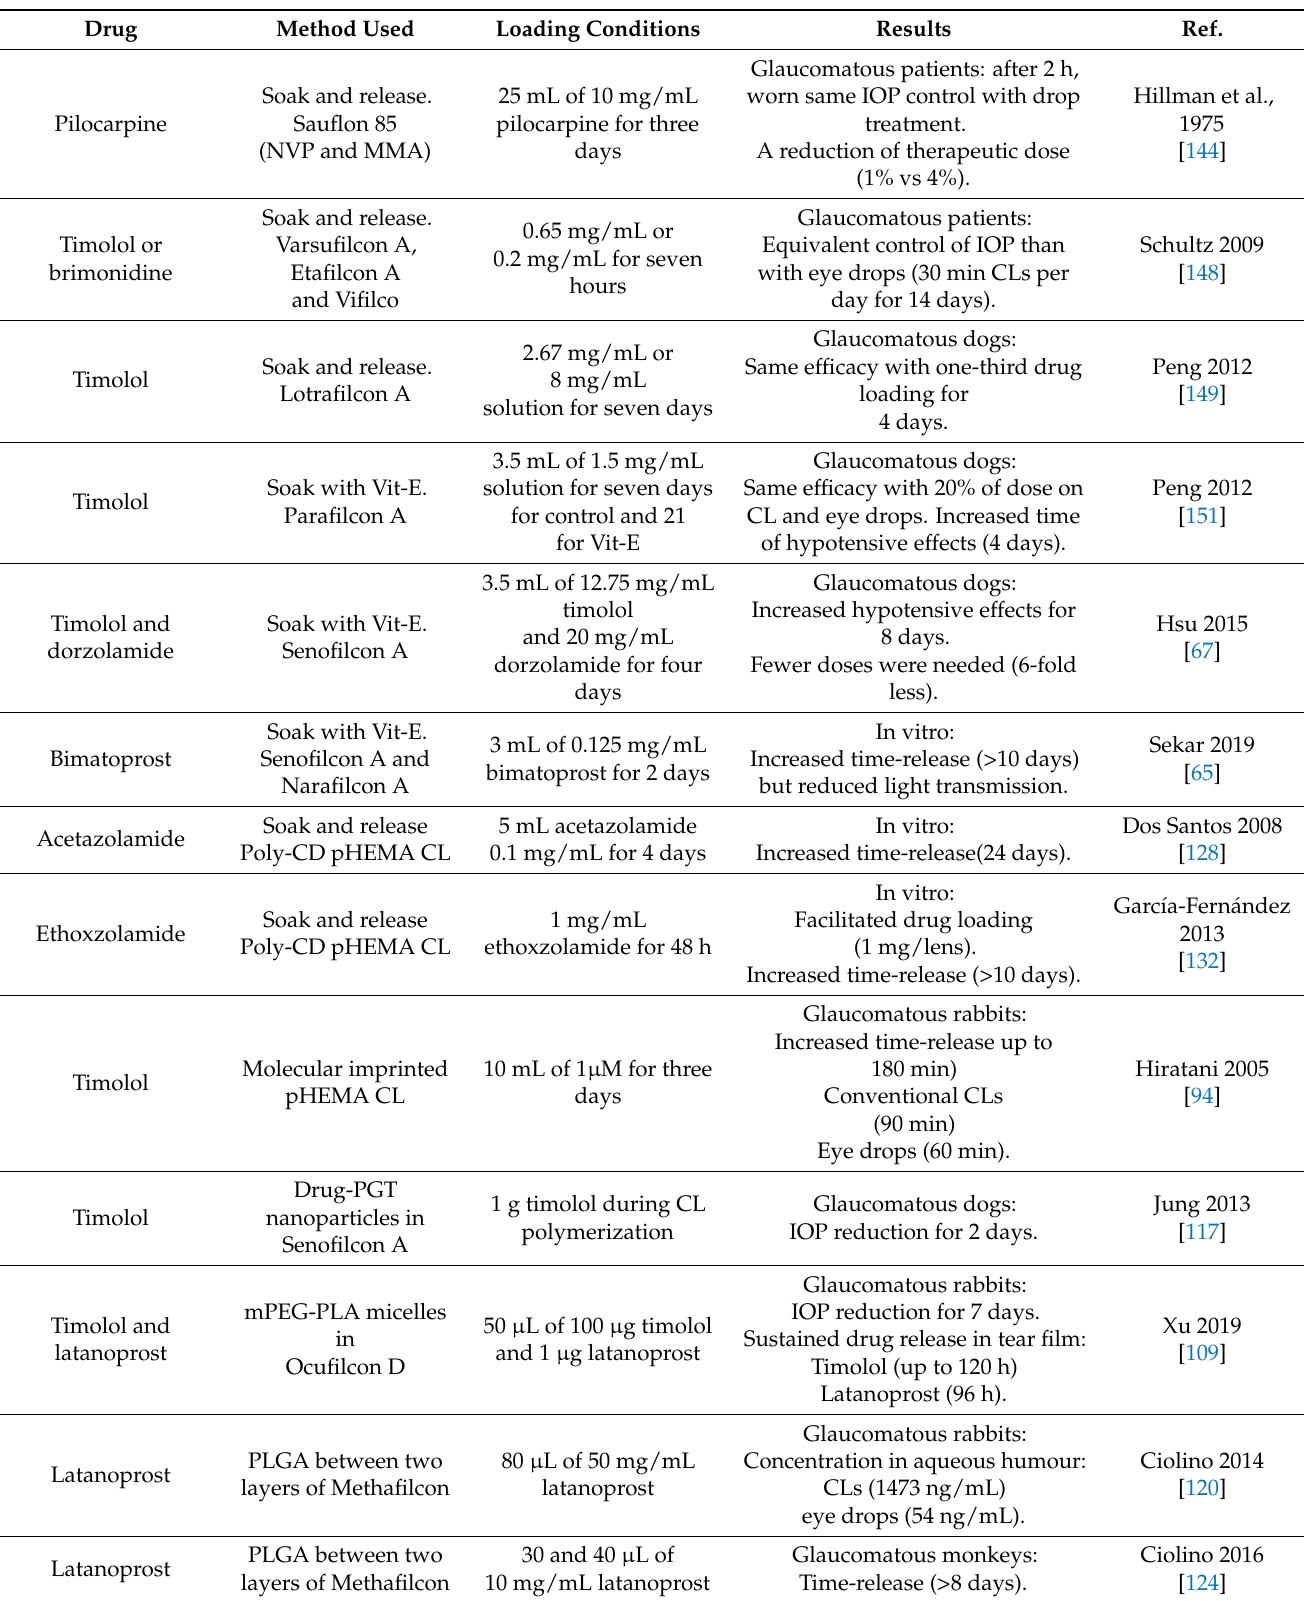
Table 6. Drugs used with SCLs as drug delivery systems for glaucoma [28].